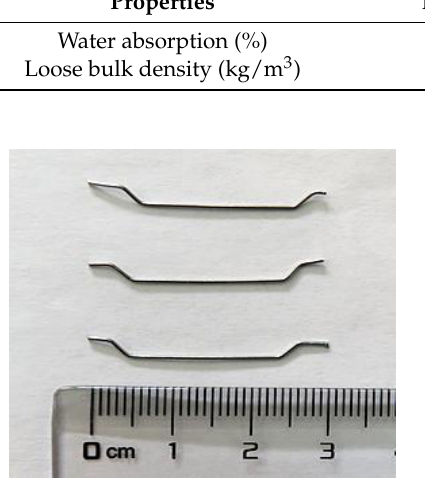
Figure 1. Steel fiber used in this test. Table 3. Properties of steel fiber.